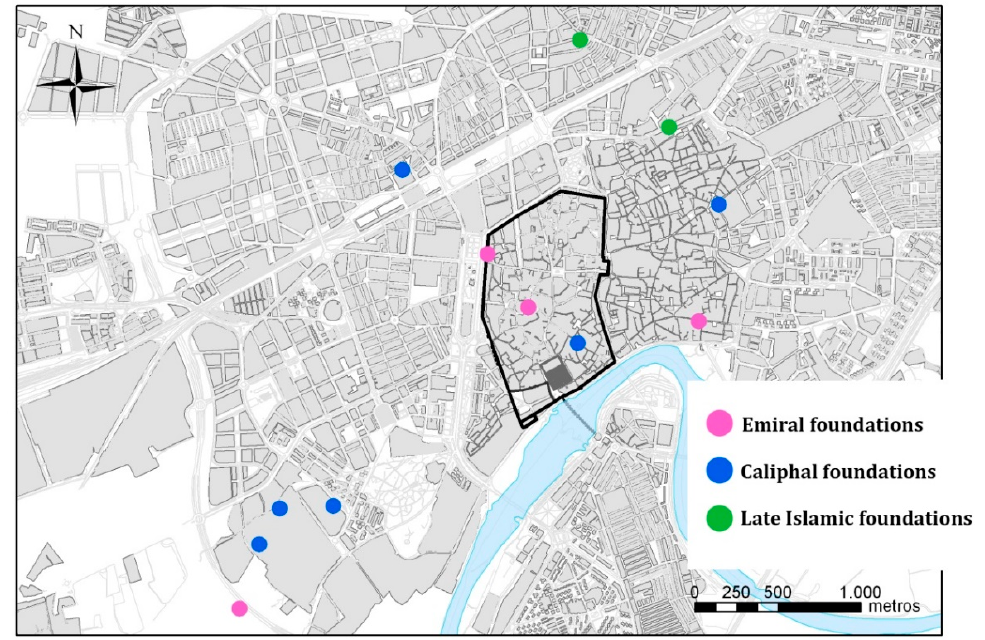
Figure 2. Dispersion map of mosques documented in Córdoba through archaeological methodologies (Created by author).